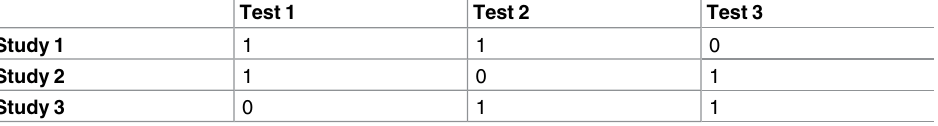
Table 1. Example of a missing data pattern, where 1 = available, and 0 = missing. For each test, and each study, there are scores missing, althoughall test co-occur at least